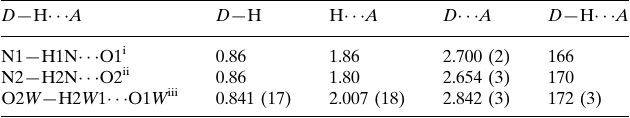
Hydrogen-bond geometry (A˚ , (cid:2)